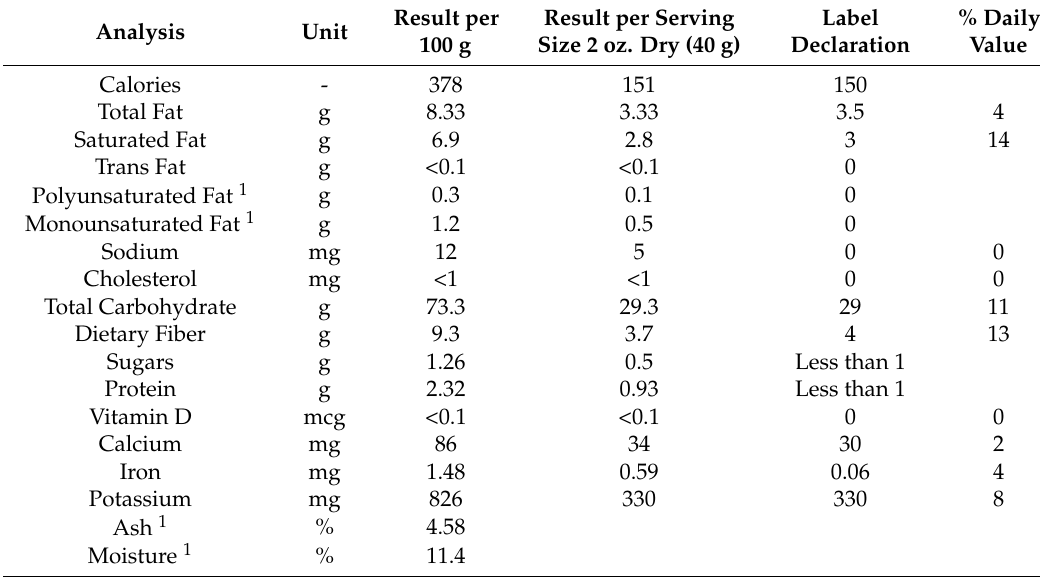
Table 2. Nutritional label analysis.